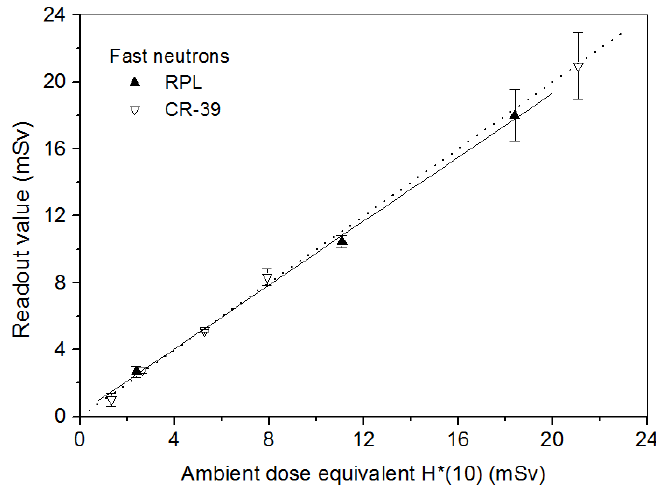
Figure 3. Linear responses of the RPL and CR-39 detectors to 241 Am-Be neutrons at normal incidence.